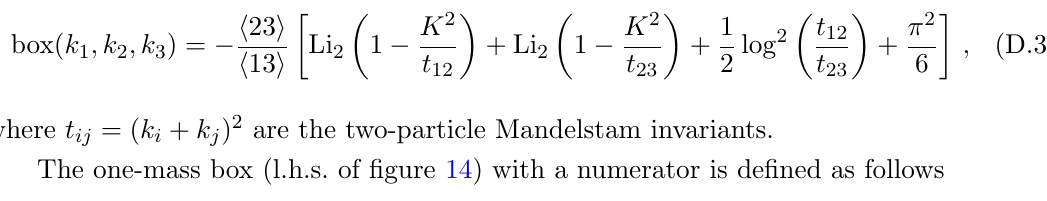
k 1 k 2 k 3 is massive. Right: pentagon with numerator (cid:0) (cid:0) (cid:0)